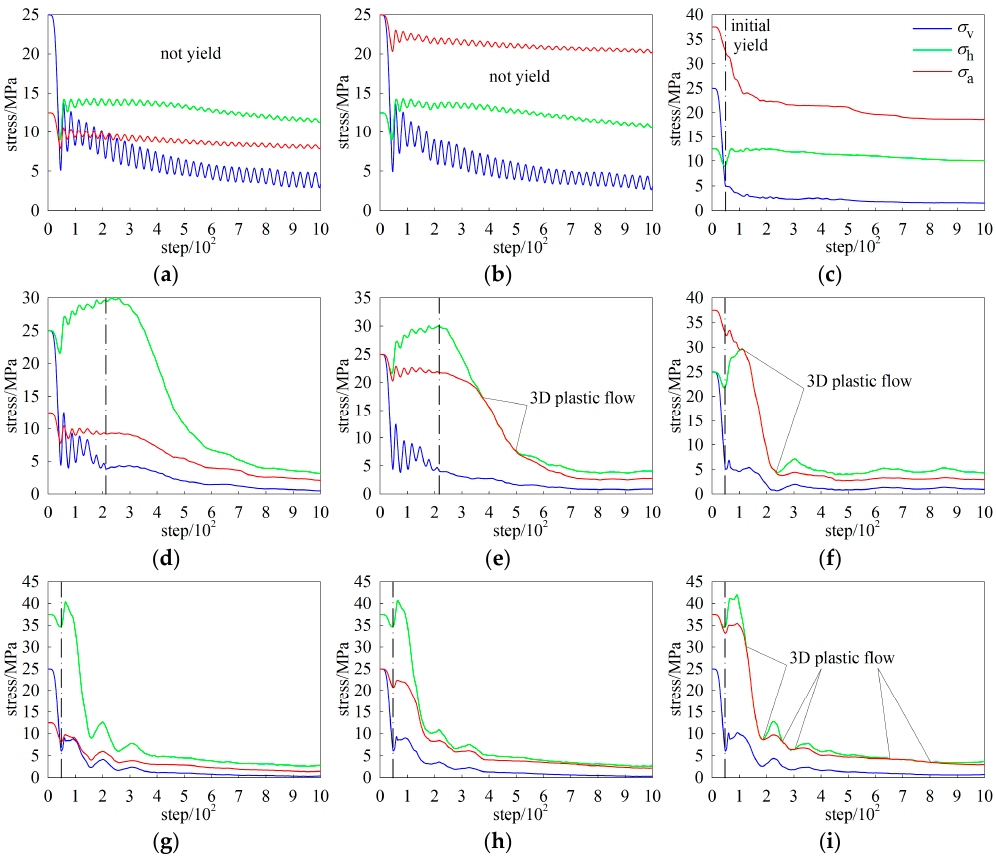
Figure 11. Monitoring results of the principal stresses: ( a ) σ h0 / σ v0 = 0.50, σ a0 / σ v0 = 0.50, ( b ) σ h0 / σ v0 = 0.50, σ a0 / σ v0 = 1.00, ( c ) σ h0 / σ v0 = 0.50, σ a0 / σ v0 = 1.50, ( d ) σ h0 / σ v0 = 1.00, σ a0 / σ v0 = 0.50, ( e ) σ h0 / σ v0 = 1.00, σ a0 / σ v0 =